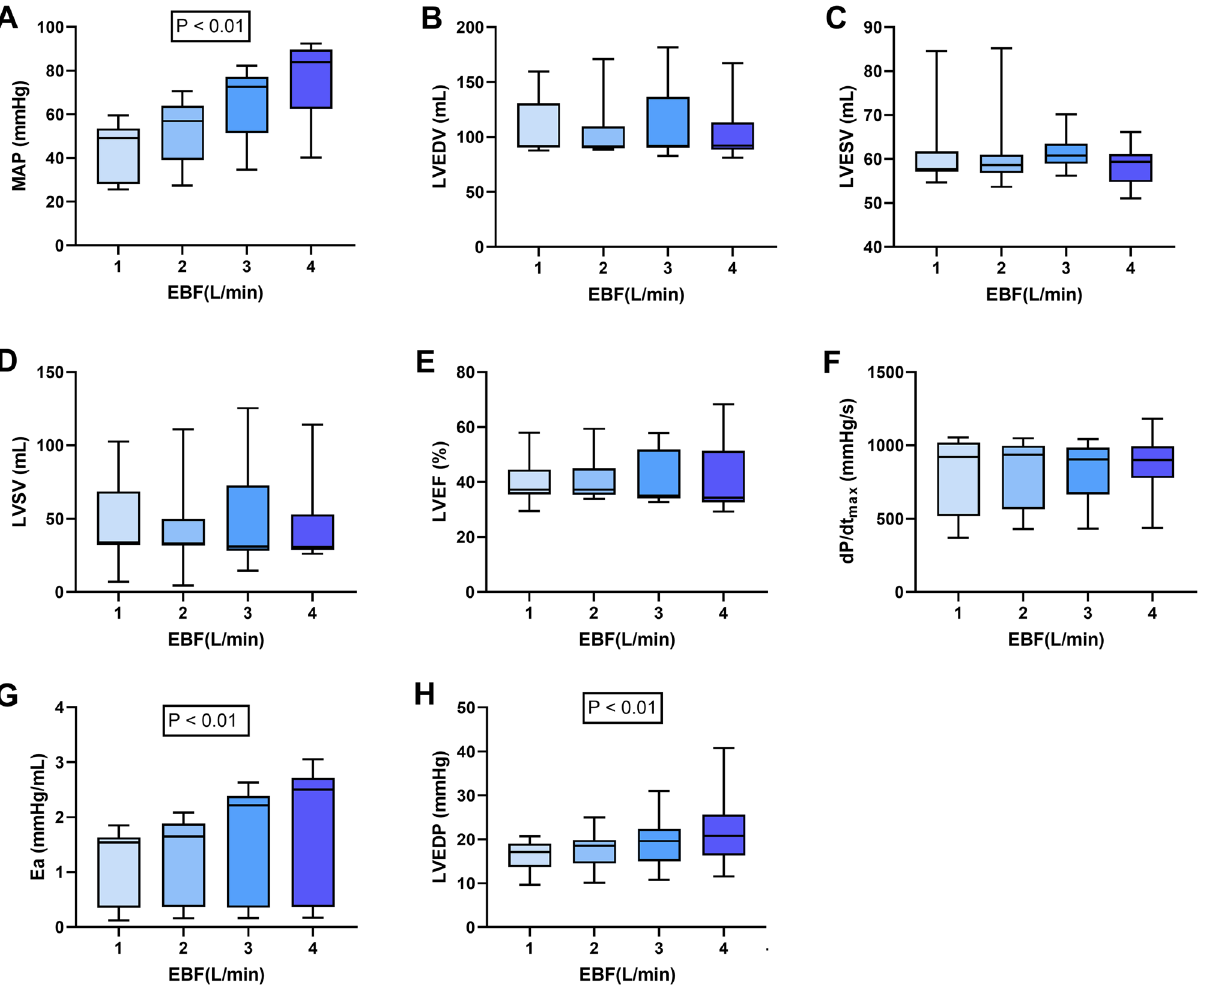
Figure 3. Comparison of the effect of different levels of venoarterial extracorporeal membrane oxygenation (VA-ECMO) blood flow (EBF) on hemodynamic and left ventricular performance parameters in a porcine model of cardiogenic shock with mitral regurgitation. ( A ) MAP, mean arterial pressure; ( B ) LVEDV, left ventricle end-diastolic volume; ( C ) LVESV, left ventricle end-systolic volume; ( D ) LVSV, left ventricle stroke volume; ( E ) LVEF, left ventricle ejection fraction; ( F ) dP/dtmax; ( G ) Ea, arterial elastance; ( H ) LVEDP, left ventricle end-diastolic